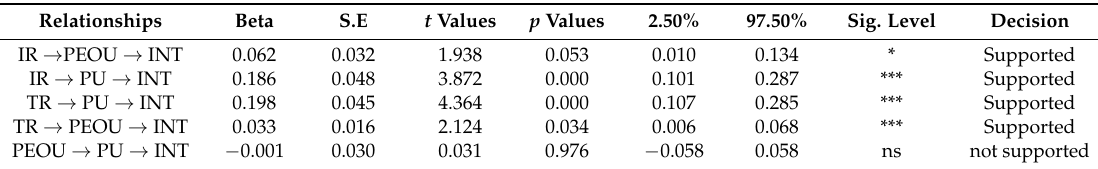
Table 6. Mediation